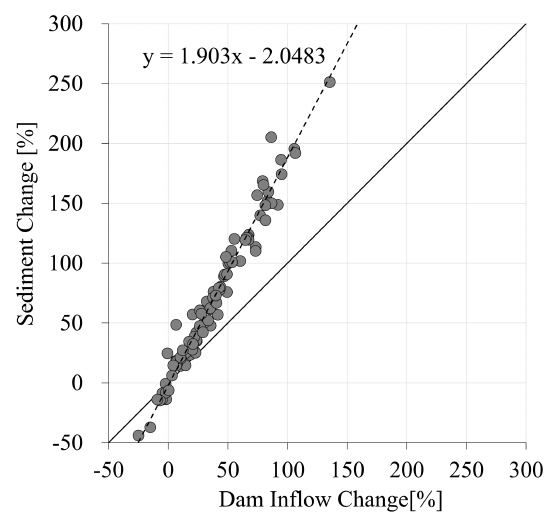
Figure 14. Relative change of sediment yield with respect to the dam